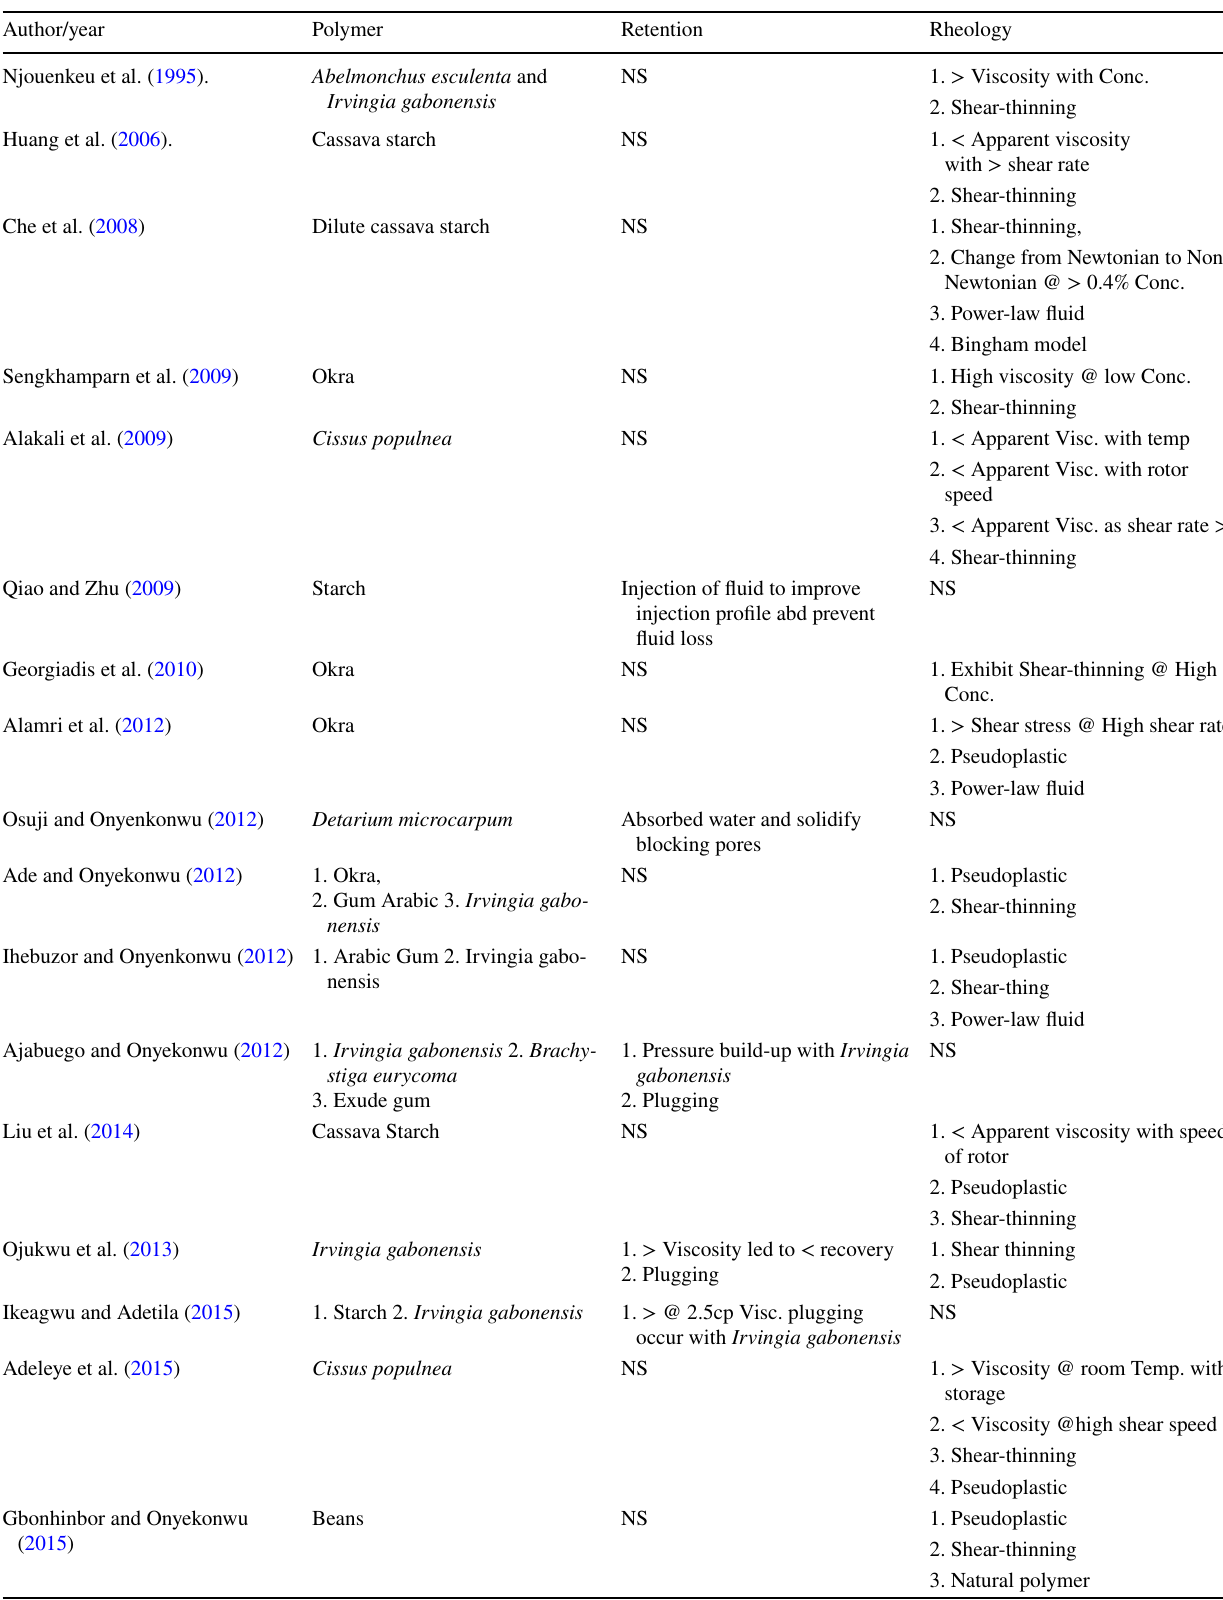
Table 2 List of studies on natural polymer flow behaviour in porous